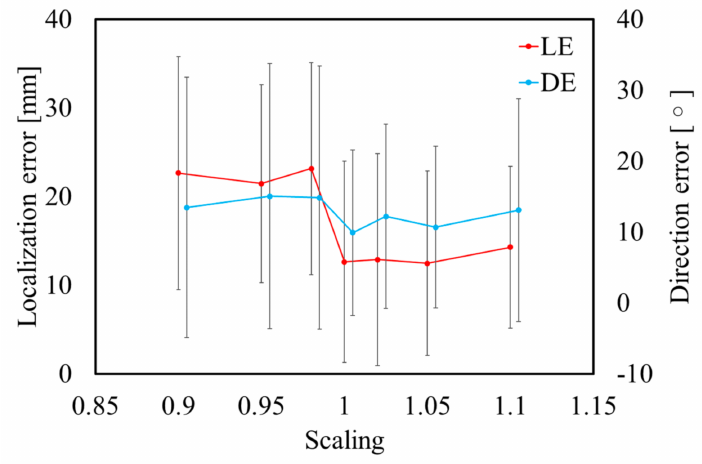
Figure 10. Variability of estimation accuracy for each rotation angle of heart with SNR = ∞ . Error bars represent standard deviation over 100 test dipoles.